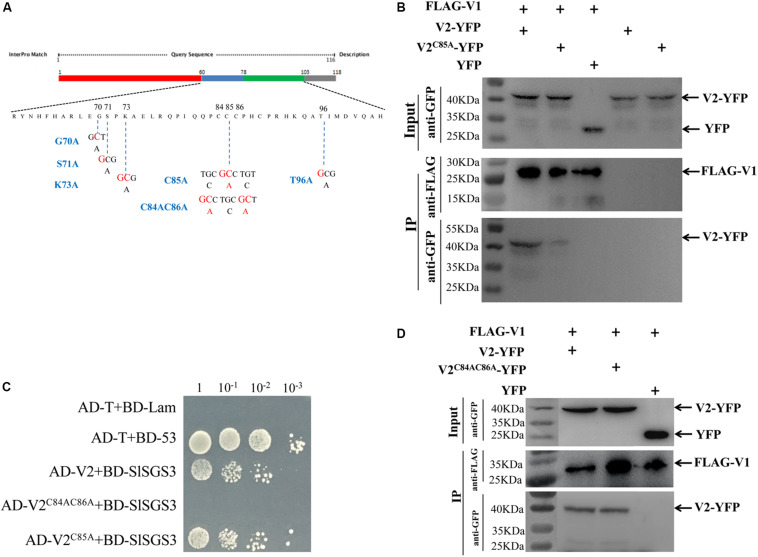
Identification of critical sites in the V2 protein responsible for the V1-V2 interaction. (A) Schematic illustration of the V2 protein. Nucleic acid and amino acid sequences of V2 mutants, V2G70A, V2S71A, V2K73A, V2C85A, V2C84AC86A, and V2T96A are shown. (B) The interaction between V1 and wt V2 or V2C85A is examined by a co-IP assay. The Co-IP assay was performed as in Figure 2A. (C) Y2H detecting possible interactions between SlSGS3 and V2C85A or V2C84AC86A. V2C85A and V2C84AC86A were fused with a GAL4 activation domain (AD-V2C85A and AD-V2C84AC86A), and SlSGS3 was fused to a GAL4-binding domain (BD-SlSGS3), respectively. AH109 cells co-transformed with the indicated plasmids were subjected to 10-fold serial dilutions and plated on synthetic-defined medium SD/-His/-Leu/-Trp medium to screen for positive interactions. Yeast cells co-transformed with AD-T + BD-53 or AD-T + BD-Lam serve as positive control or negative controls, respectively. (D) Co-IP assay to show the interaction between V1 and V2 or V2C84AC86A. The Co-IP assay was performed as in Figure 2A.